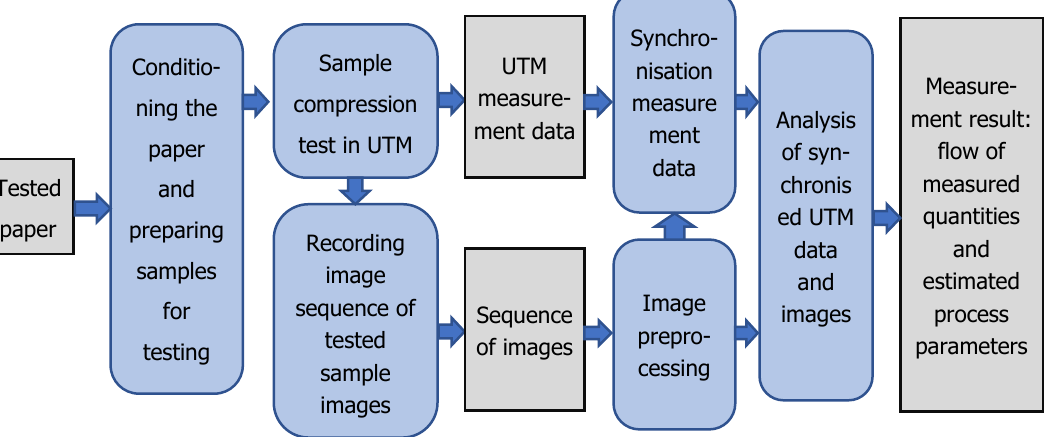
Figure 2. Flow diagram of the entire measurement procedure.